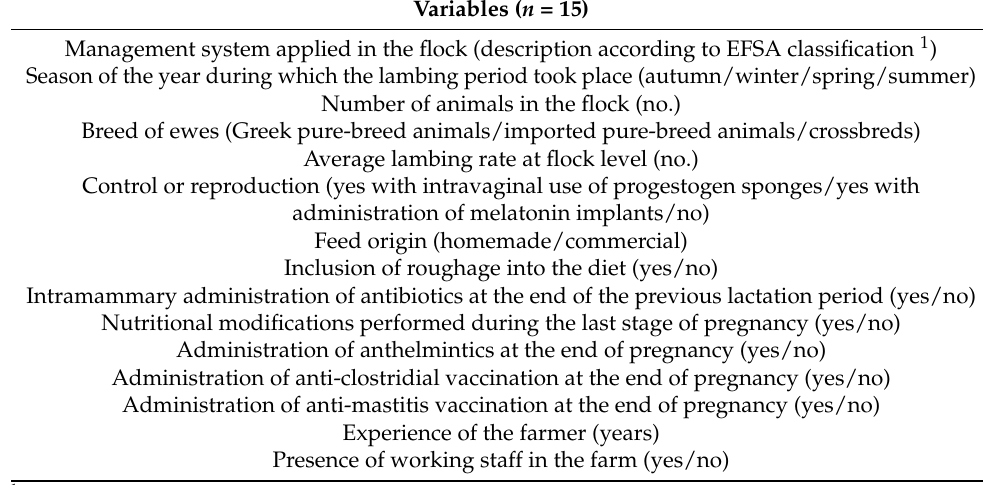
Table A1. Variables ( n = 15; flock-level factors) evaluated for potential association with peri-parturient deaths in 60 sheep flocks in Greece.